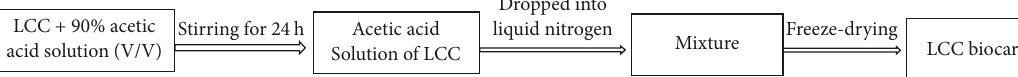
Figure 3: Preparation of LCC-based spherical